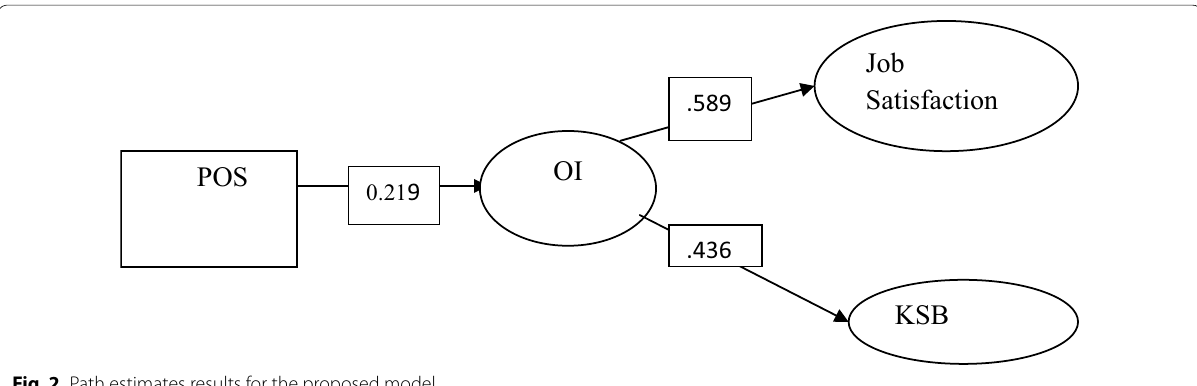
Fig. 2 Path estimates results for the proposed